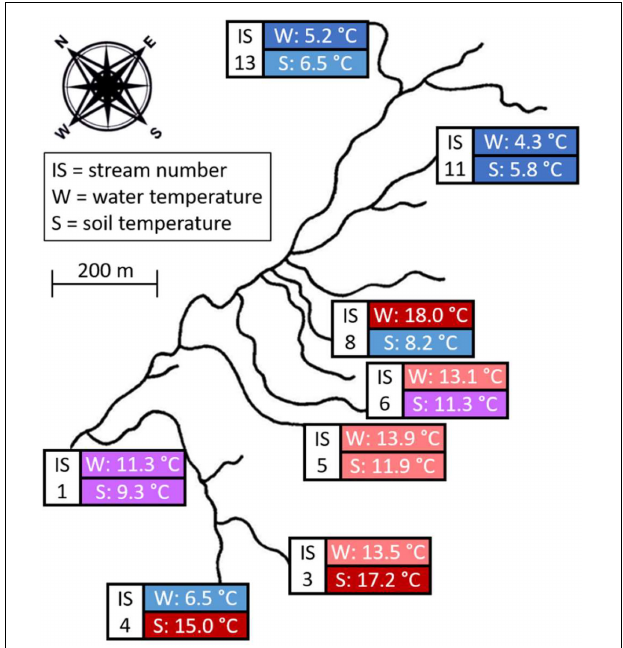
FIGURE 1 | Map of the study site, with sampled streams and soil habitats indicated by colored boxes. Stream numbers correspond to the coding used in previous Hengill publications (e.g., Woodward et al., 2010). The mean water (W) and soil (S) temperatures during the study period are also provided and colored accordingly, ranging from dark blue (cold) to dark red